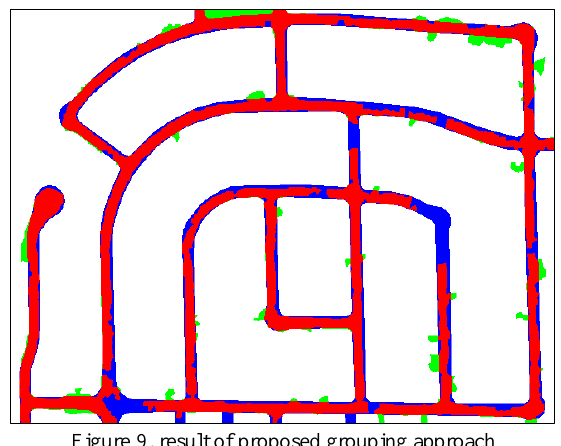
Figure 9. result of proposed grouping approach The quantitative evaluation results are shown in Table 1.